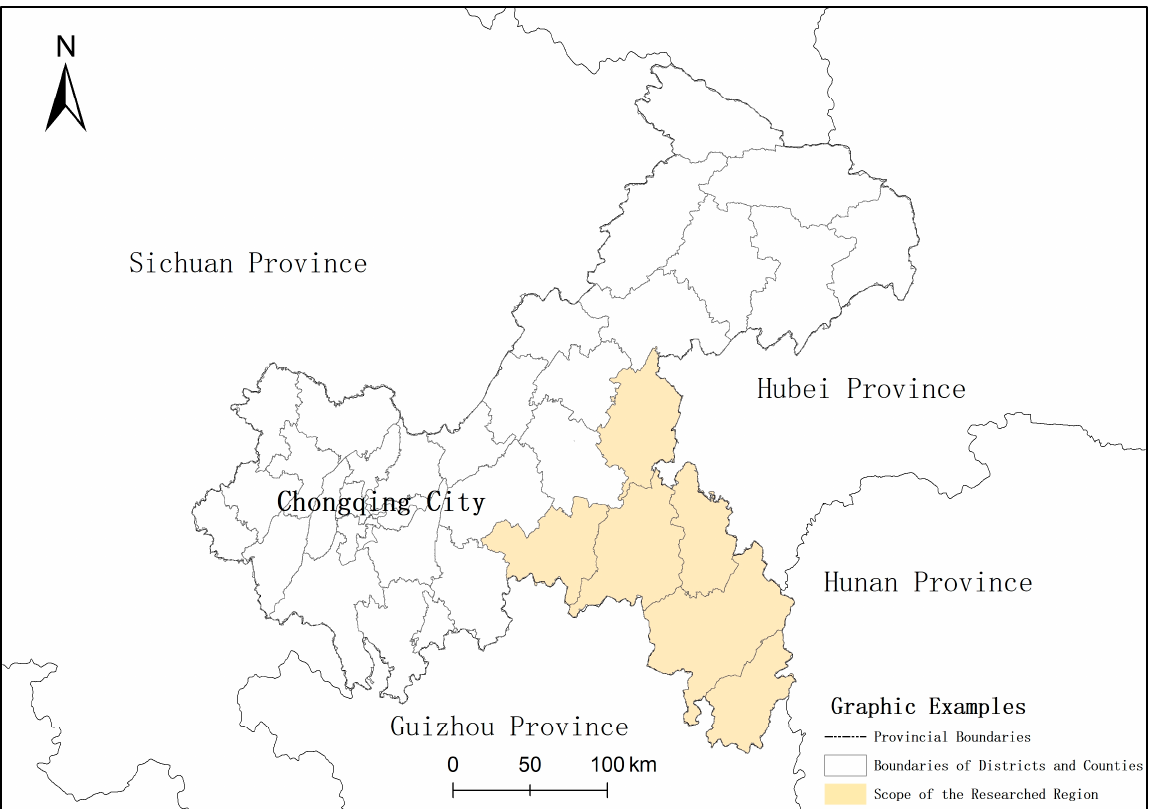
Figure 1. Scope of the Researched Region.